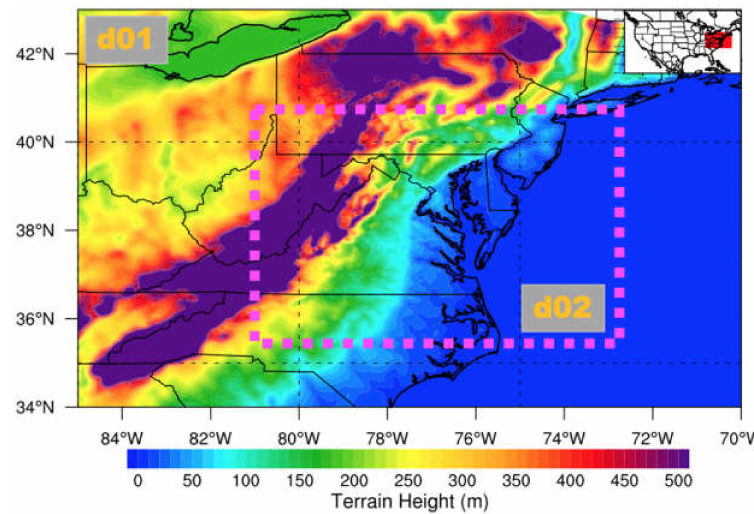
Figure 1. Terrain height of the area surrounding CB over the eastern U.S. The outer domain is denoted as d01 and the nest domain is enclosed within the pink dashed rectangle (d02). The insert map in the top-right corner shows the location of the study region (red shading) over the continental U.S.